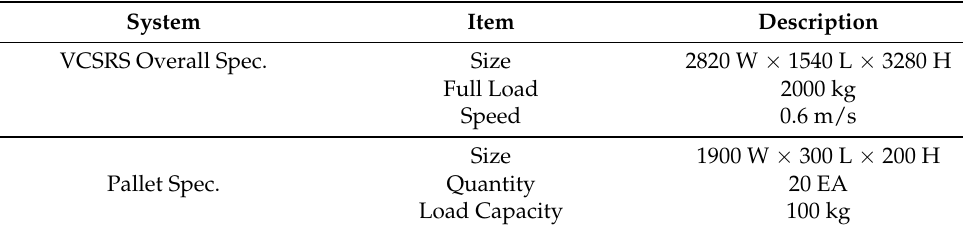
Figure 6. Pictorial view of the vibration sensor placement on the vertical carousel storage and retrieval system. Table 2. VCSRS Design